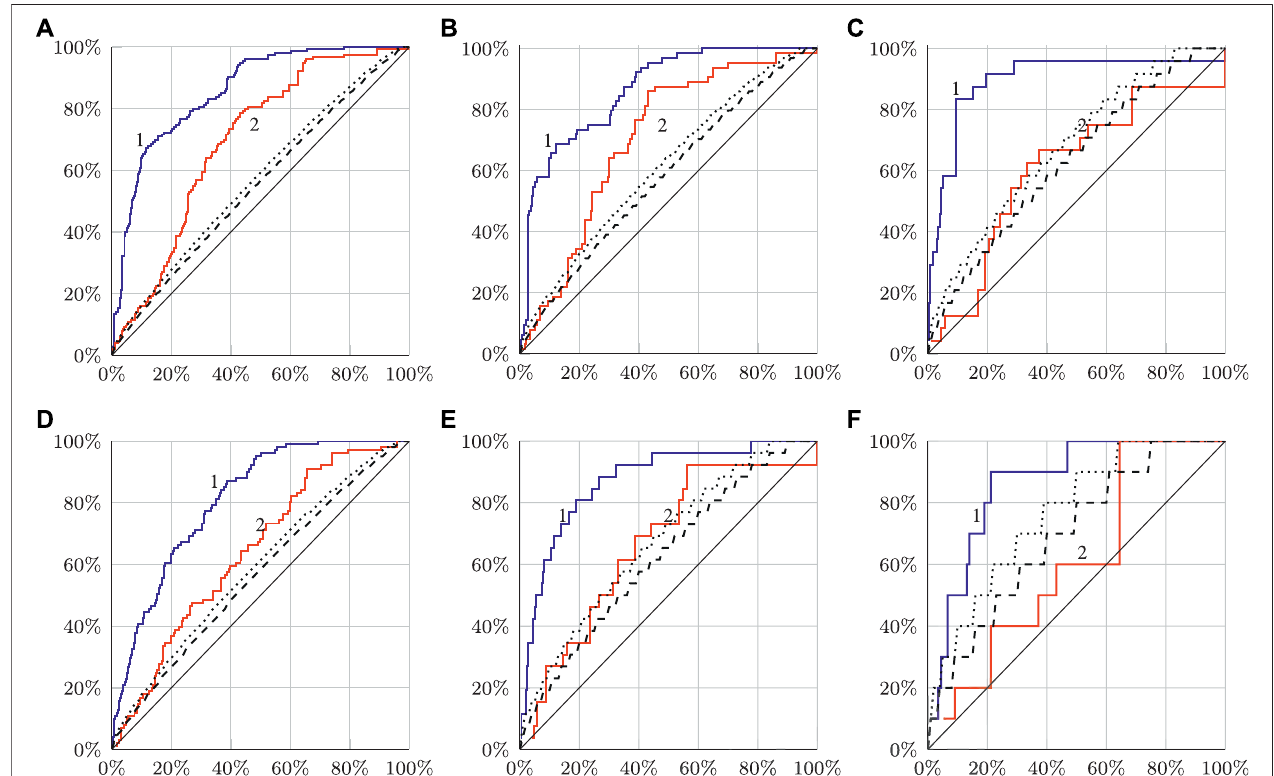
FIGURE2| Graphs ofdependencies U ( V ) : (A) – (C) are theplotsof U ( V ) forthe Kamchatka magnitude intervals m ∈ [ 5 . 0 , 5 . 4 ] , m ∈ [ 5 . 5 , 5 . 9 ] , m ≥ 6 . 0; (D) – (F) are the plots of U ( V ) for the Aegean Region magnitude intervals m ∈ [ 5 . 0 , 5 . 3 ] , m ∈ [ 5 . 5 , 5 . 8 ] , m ≥ 5 . 9; 1 labels the plots obtained for regular forecasting; 2 labels the plots obtained using the spatial density fi eld F 6 ; dotted and dashed lines are associated with 99 and 95% con fi dence levels correspondingly.